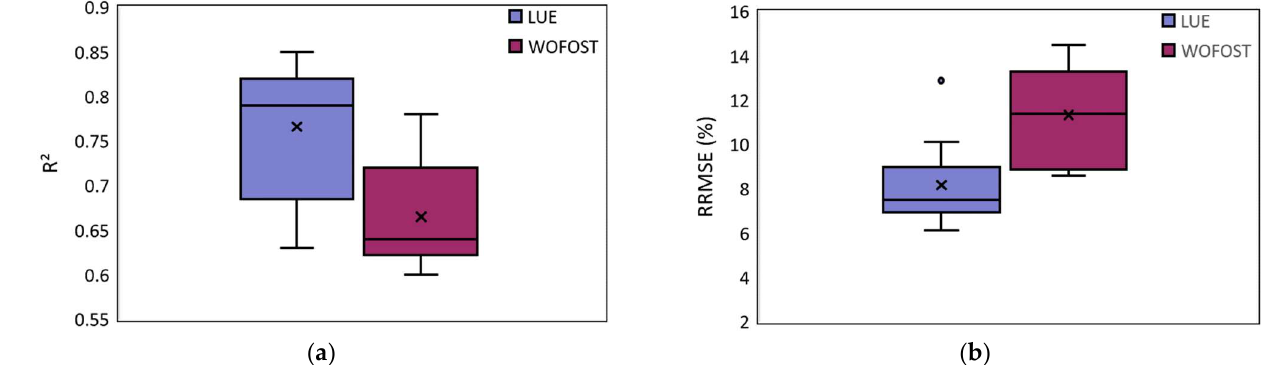
Figure 15. The dot plots show the comparison of accuracies for ( a ) R 2 , ( b ) RMSE, ( c ) RRMSE, and ( d ) ME values obtained from the referenced yields (at 95% confidence interval) for LUE (dark blue) and WOFOST (dark pink) models.